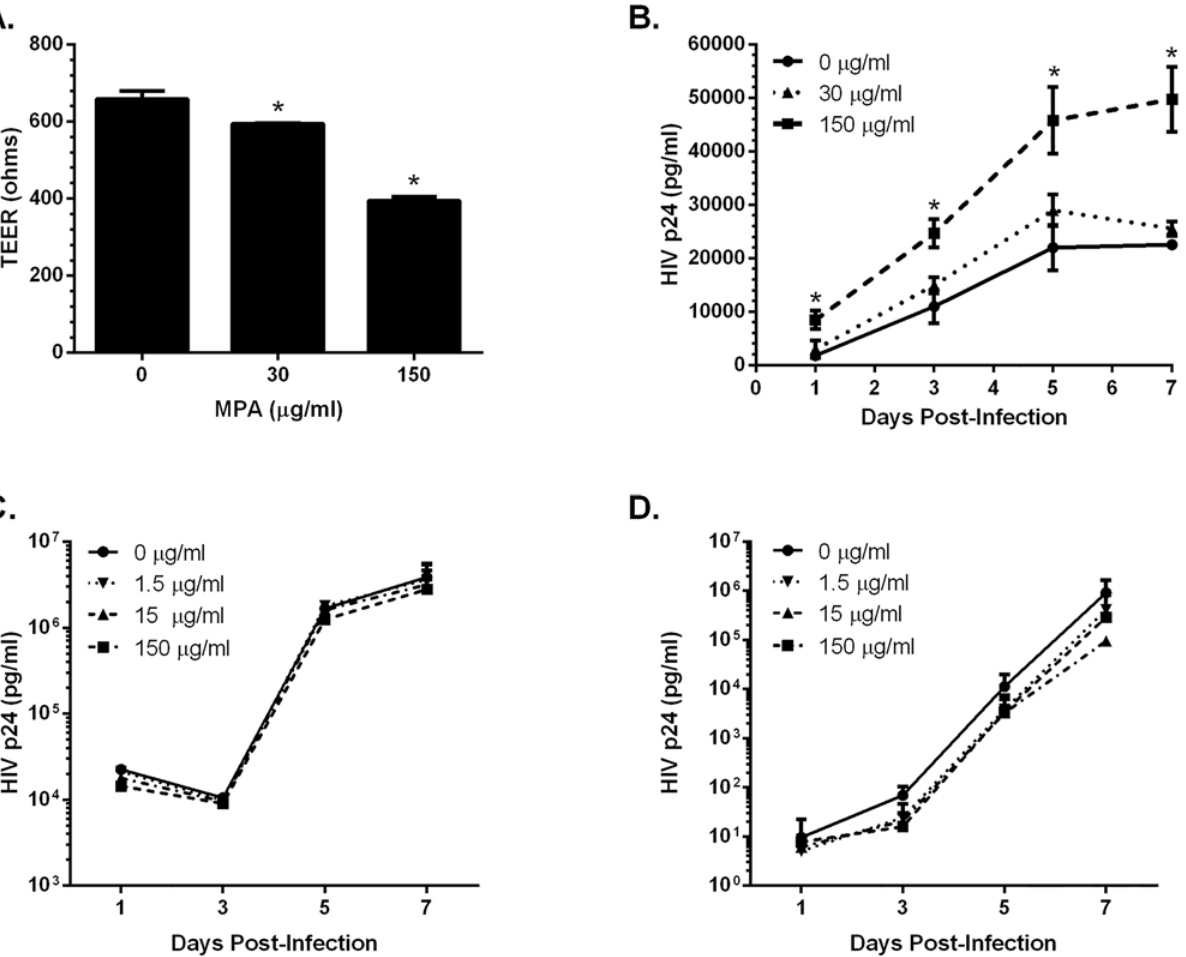
Fig 5. MPA decreased TEER and increased HIV transmission across polarized cells. HEC-1-A cells were plated in the apical chamber of transwell culture plates in the presence or absence of the indicated concentrations of MPA and TEER was monitored daily until at least 400 ohms was maintained. Representative TEER results from duplicate wells on Day 4 are shown (A). HIV (40 ng p24) was added to the apical chamber and JT-CCR5 cells were added to the basolateral chamber and transmigration and infection were monitored by analyzing basolateral culture supernatants for p24 by ELISA on days 1, 3, 5, and 7 post-addition of HIV to the apical compartment (B). Alternatively, JT-CCR5 cells were exposed to HIV (4.8 ng p24) either when cells were added to the basolateral chamber (C) or were exposed to HIV in a 96-well plate, washed, and then added to the basolateral chamber (D) and HIV replication was again monitored over time. Asterisks indicate statistically significant differences compared to mock-treated cells, p < 0.05, Student ’ s t-test.